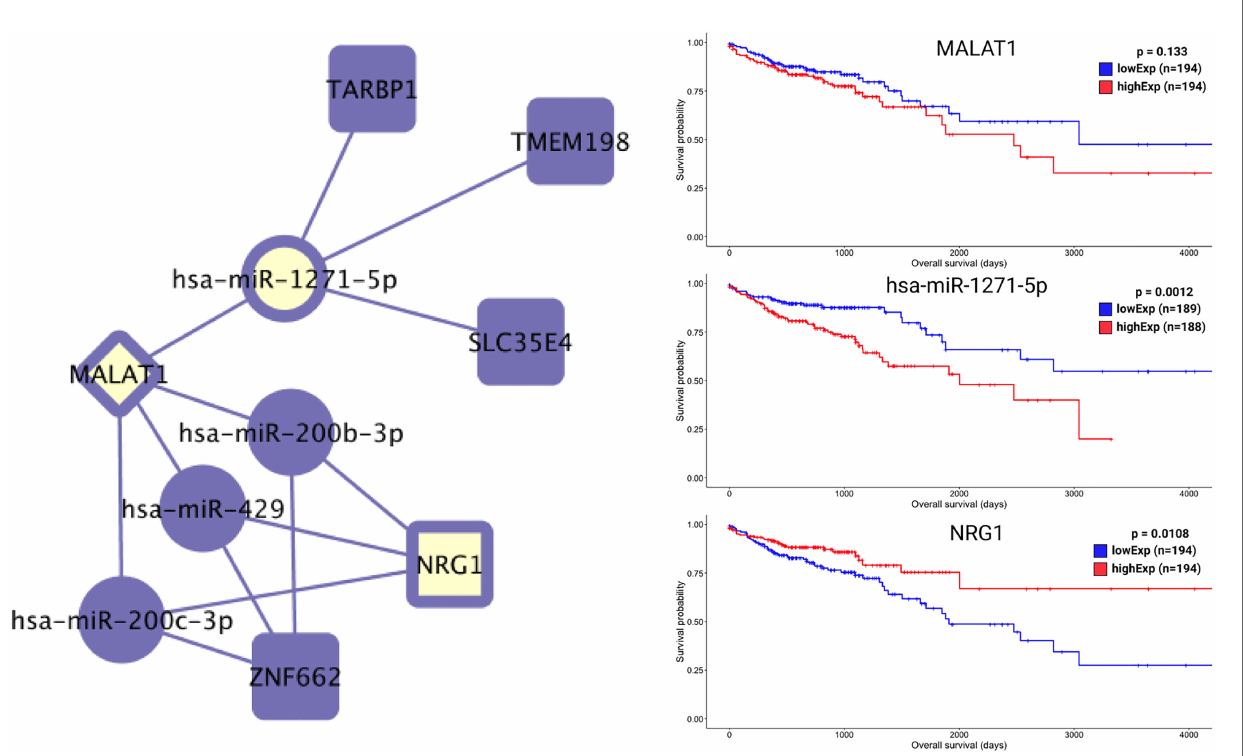
FIGURE 9 | Colon-speci fi c ceRNA network and overall survival for hsa-mir-1271-5p, NRG1 and MALAT1. Here, we can see the opposing putative roles of hsa-mir- 1271-5p and NRG1 on overall survival time. MALAT1 is shown as a link that relates hsa-mir-1271-5p and NRG1 regulation, as well as behaving like hsa-mir-1271- 5p on patient overall survival